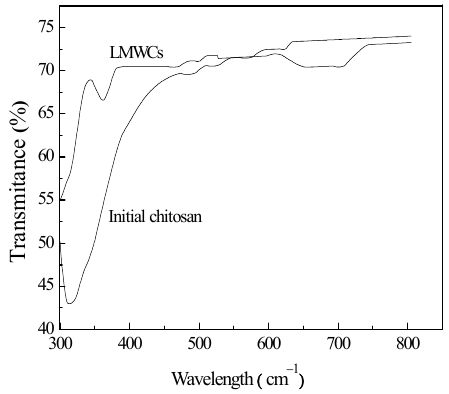
Figure 5. UV-VIS transmittance spectra of initial chitosan and LMWC samples.